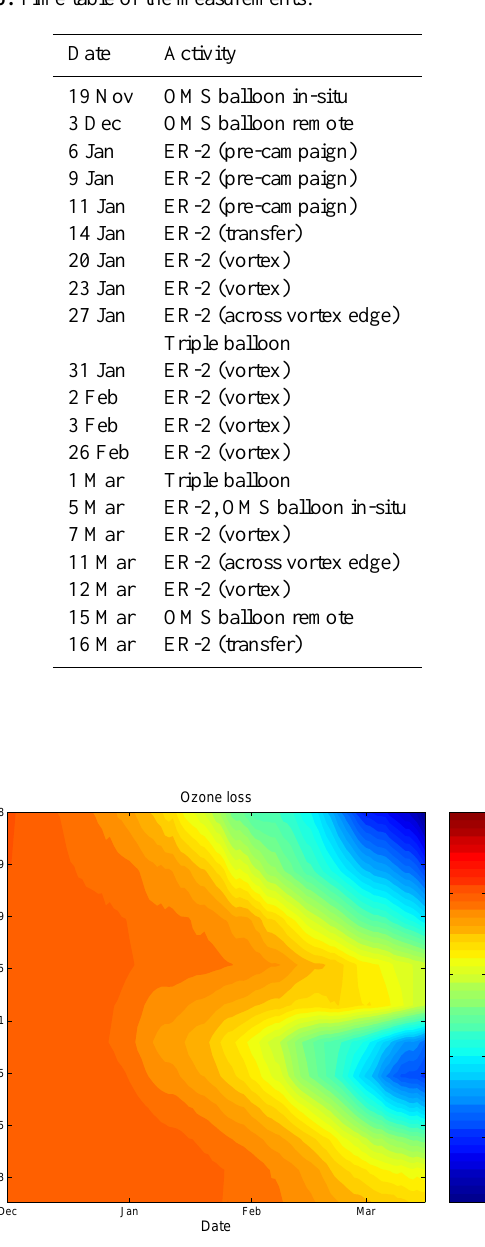
Fig. 2. Vortex-averaged ozone loss as function of model date and al- titude. Difference between the passive ozone tracer and the modeled ozone averaged over all air parcels inside the inner vortex boundary according to the Nash criterion (Nash et al., 1996) and over several hybrid coordinate (i.e. potential temperature) intervals equivalent to the mixing depth of the model. Before 24 December 1999, the Nash criterion is not applicable and replaced by a constant value of 67 ◦ equivalent latitude.